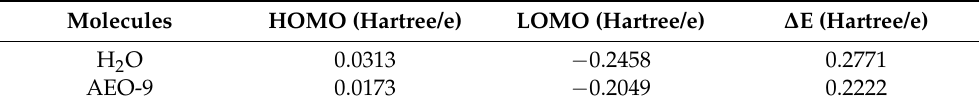
Table 2. HOMO and LOMO orbital energy values of H 2 O and AEO-9 molecules.